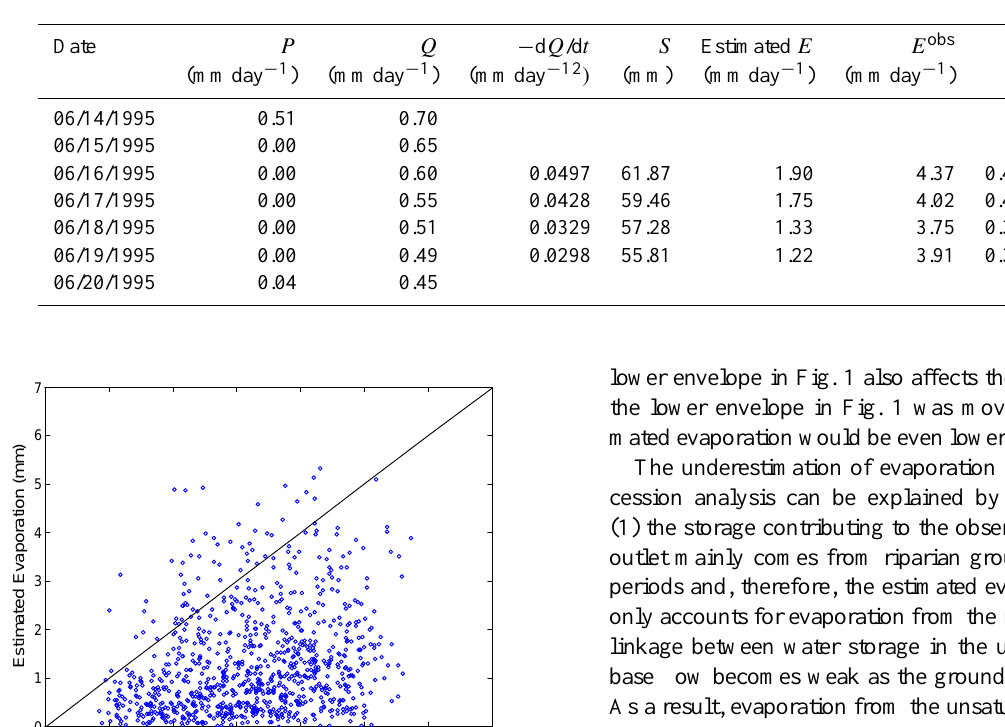
Table 2b. One recession event from the Nodaway River watershed in Iowa in June 1995.